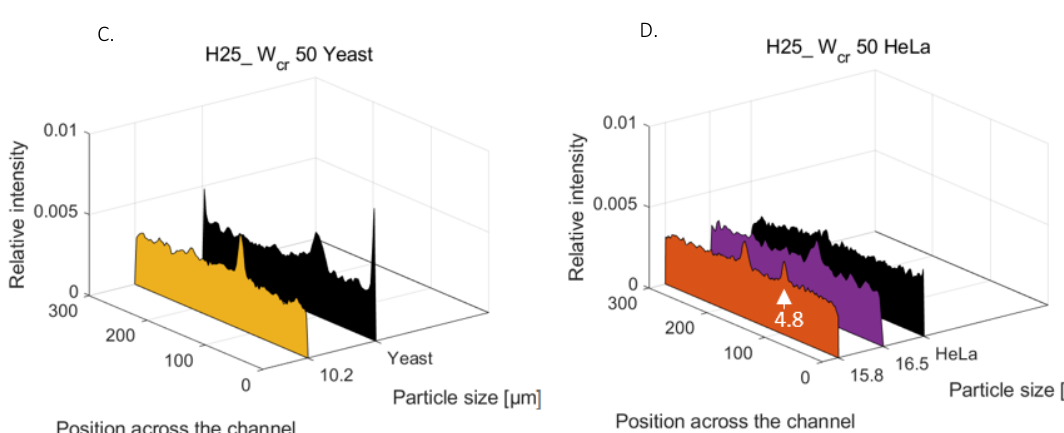
Figure 6. Experimentally determined lateral distributions of the studied biological cells and their model beads developed in the periodically inhomogeneous curvilinear-focusing microfluidic channel in H25_W cr 50 at 1µL/s flow rate: ( A ) for E. coli with polystyrene beads of Ø 0.5, 1.1 and 1.97 µm; ( B ) for Red blood cells (RBC) with beads of Ø 2.9, 4.8, 5.4 and 6.08 µm; ( C ) Saccharomyces cerevisiae (Yeast) with bead of Ø 10.2 µm; ( D ) HeLa cells with polystyrene beads of Ø 4.8, 15.8 and 16.5 µm.